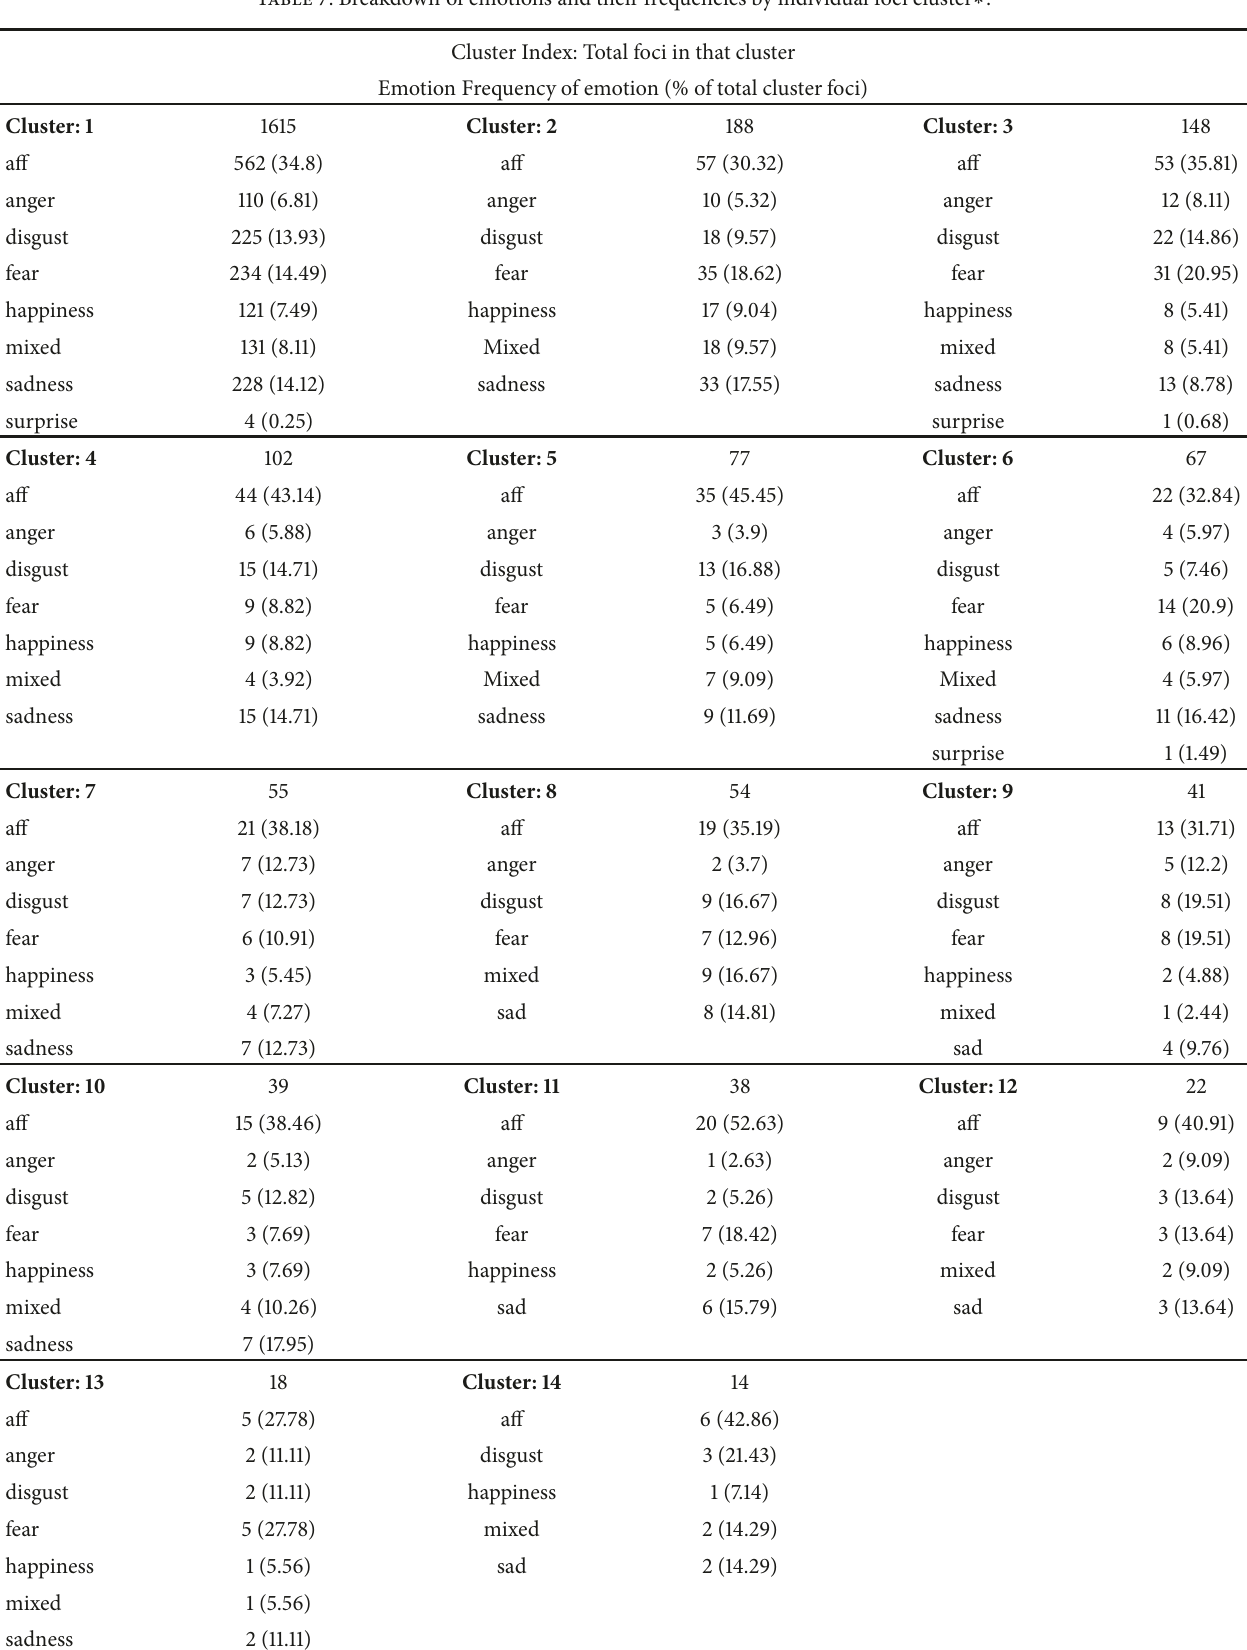
Table 7: Breakdown of emotions and their frequencies by individual foci cluster ∗ . Cluster Index: Total foci in that